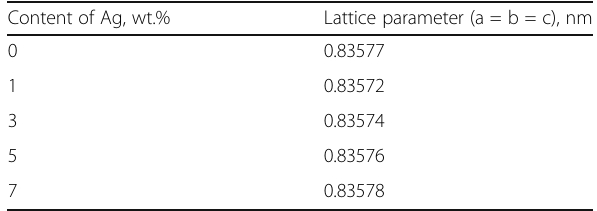
Table 1 Lattice parameters of the Li 4 Ti 5 O 12 /Ag composites coated with different Ag contents Content of Ag,